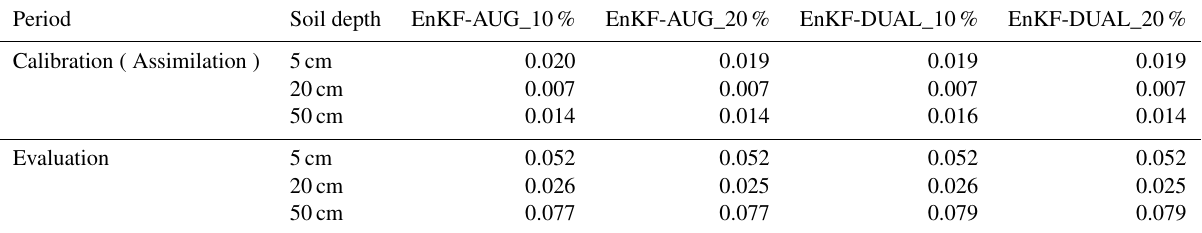
Table 6. RMSE values of VIC-3L for the Rollesbroich soil moisture measurements at 5, 20, and 50cm depths using the EnKF with state AUGmentation or DUAL estimation during the calibration period. We also summarize the subsequent performance of the VIC-3L model using the calibrated parameter values and initial states derived from AUG and DUAL. The subscripts 10 and 20% signify the standard deviations of the measurement errors that are used to corrupt the hourly precipitation data.